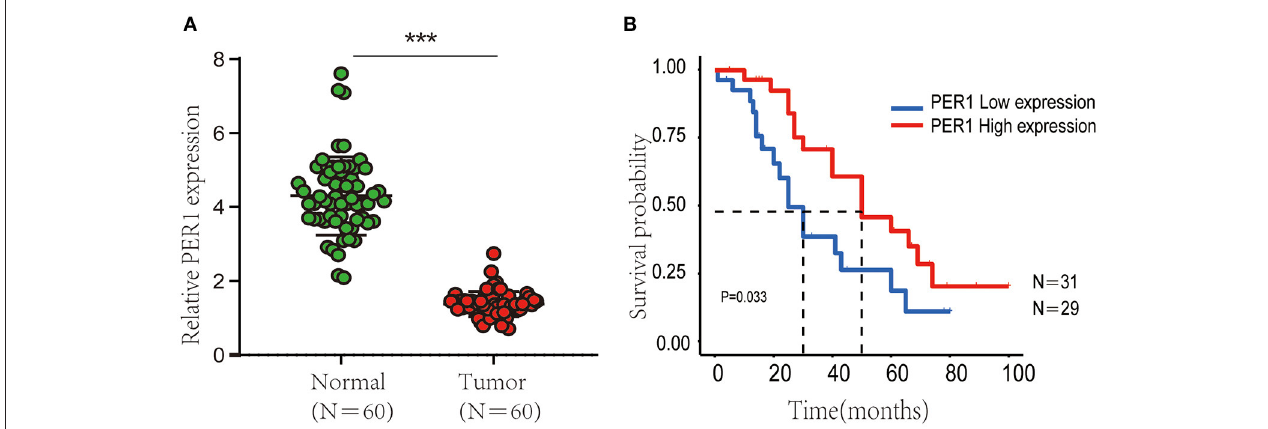
FIGURE 8 | Expression of PER1 in 60 normal and tumor samples. (A) Kaplan–Meier OS analysis of Chinese OV patients based on expression of PER1 (B) . *** p <